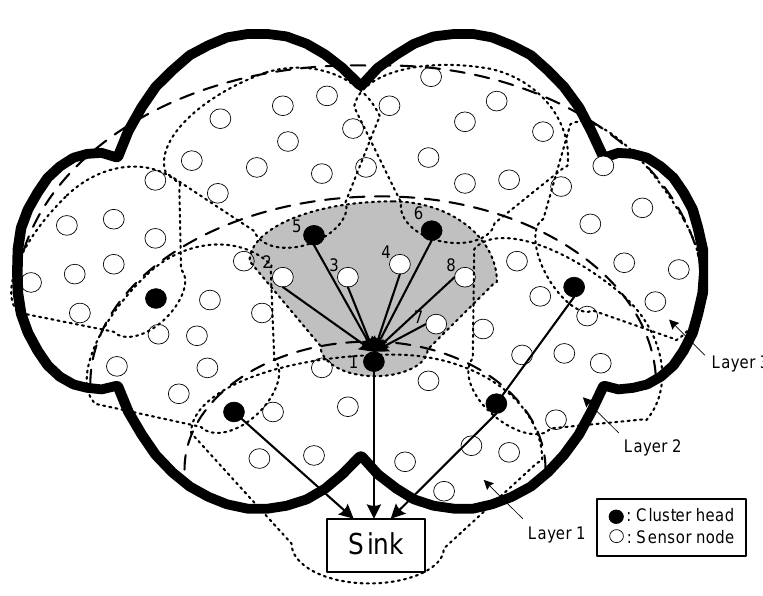
Figure 1. Structure of PMRC-based